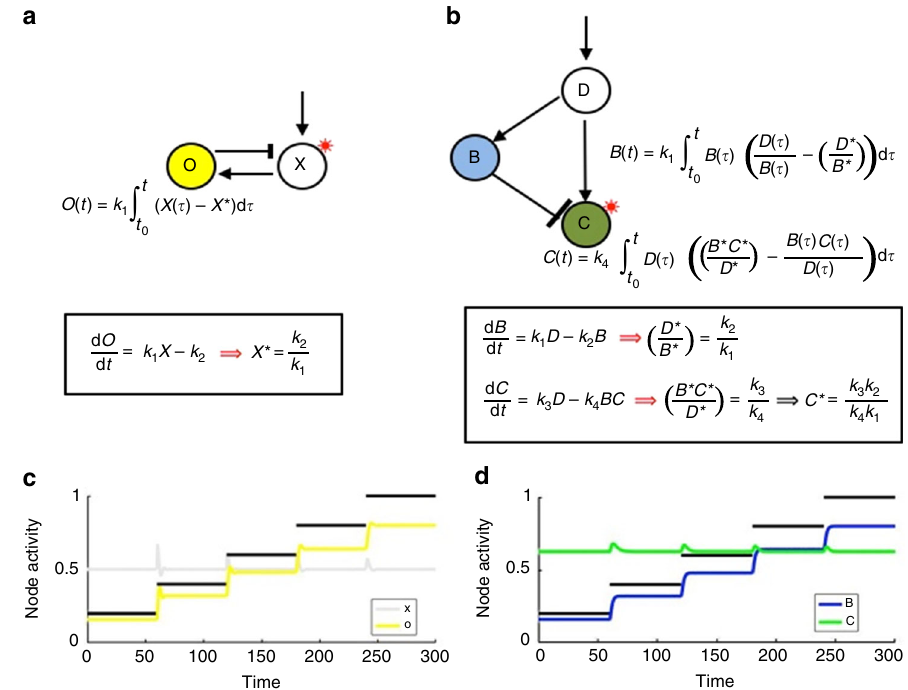
Fig. 2 Integral control in opposer and Balancer Modules. Solving the RPA problem in general networks relies on the computation of two different types of integral — one for each type of RPA basis module. a In an Opposer Module, each opposer node computes a tracking error that involves the activity of its single independent regulator. For the minimal example of an Opposer Module shown here, the single opposer node O exhibits a simple form of opposer kinetics which is zero-order in its substrate, with single independent regulator X. The opposer thereby computes the tracking error between the activity of X and its (input-independent) steady-state value, X *. b In a Balancer Module, it is the role of the balancer nodes to compute a steady-state activity ( B *) that is a linear function of the steady-state of the diverter node ( B *). Each balancer thereby computes an integral that involves the deviation of the nodes ’ activities from a linear relationship. This upstream computation then creates the conditions for the connector node to track a steady-state value ( C *) that is independent of the activity of the D-node through the computation of an integral involving its direct regulators. For the minimal example of a Balancer Module shown here, the balancer tracks the simplest linear relationship with the diverter activity, namely a proportional relationship. c Numerical simulations for the simple Opposer model shown in a : input ( I ) (shown in black) increases from 0.2 to 1 in steps of 0.2. X -equation: d X /d t = k 3 ( I / O ) – k 4 X ; parameters: k 1 = k 4 = 1, k 2 = 0.5, k 3 = 0.4. d Numerical simulations for the simple Balancer model shown in b . Input ( I ) (shown in black) increases from